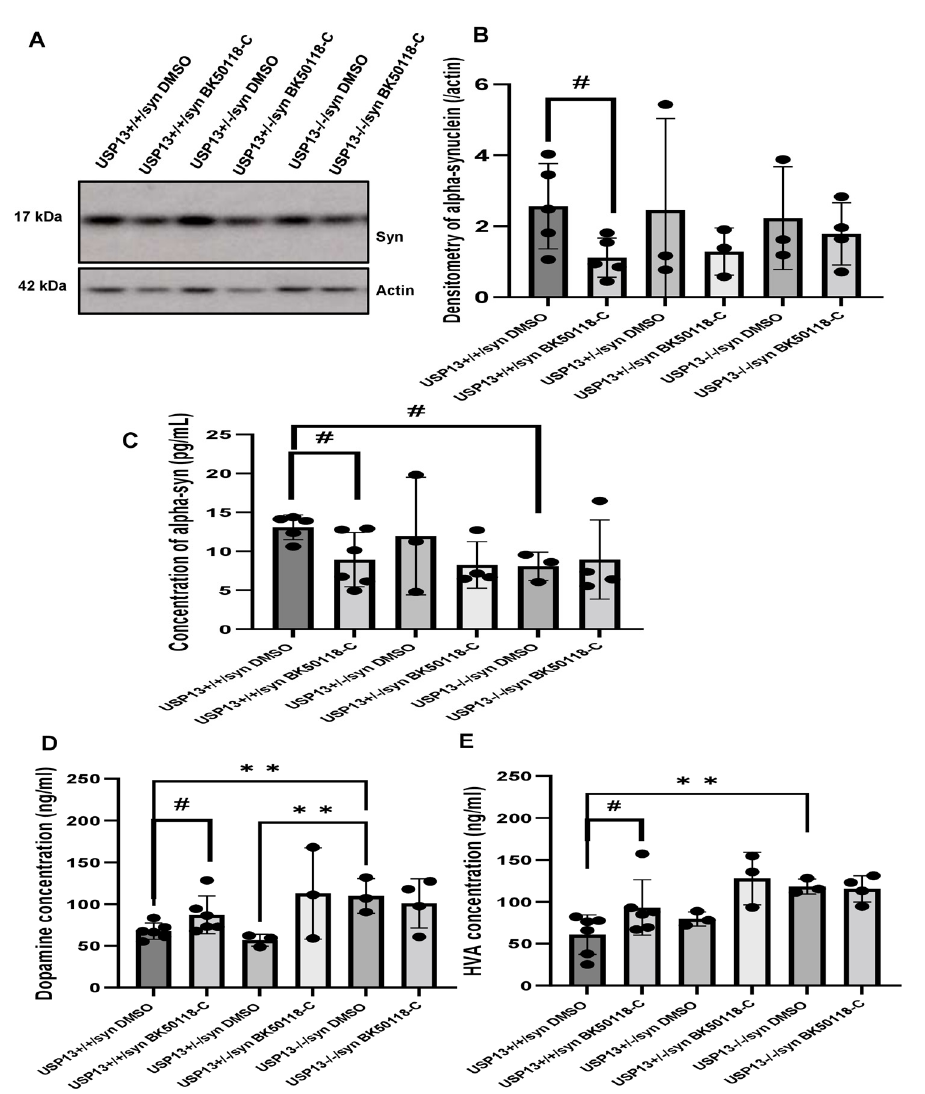
Figure 5. BK50118-C reduces alpha-synuclein and protects against dopamine loss in USP13 +/+ , but not USP +/ − or USP13 − / − brain. WB of STEN (soluble) midbrain extracts of ( A ) USP13 +/+ , USP +/ − and USP13 − / − mice, which were injected with lentiviral alpha-synuclein into SN and treated with BK50118-C or DMSO showing alpha-synuclein (17 kD) level relative to actin (42 kD) on 4–12% Criterion™ XT Bis-Tris Protein Gel, and ( B ) alpha-synuclein densitometry. ELISA measuring levels of ( C ) human alpha-synuclein ( D ) dopamine, and ( E ) HVA in same brain extracts. The asterisk indicates statistically significant difference. One-way ANOVA ** p < 0.01. Two tailed Student’s t test, and non parametric tests # p < 0.05. n = 3–6 per group. Mean ± SD. The black dot • represents each individual data.